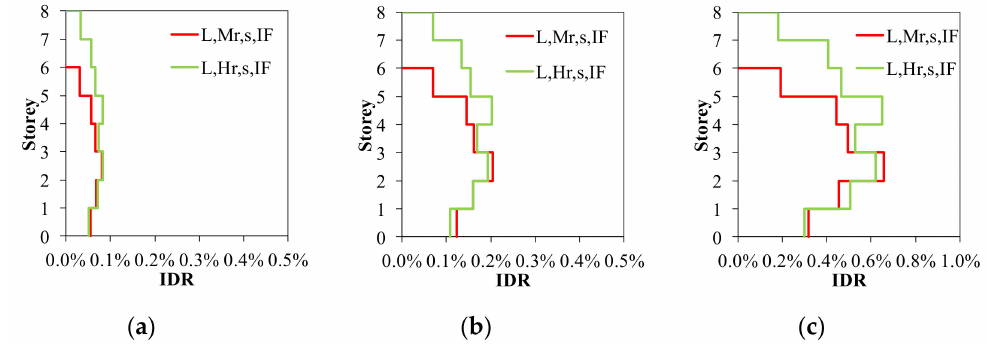
Figure 10. Maximum interstory drift profiles (computed as average between the two principal directions) at ( a ) ZL, ( b ) O, and ( c ) DC performance levels for the L-archetype